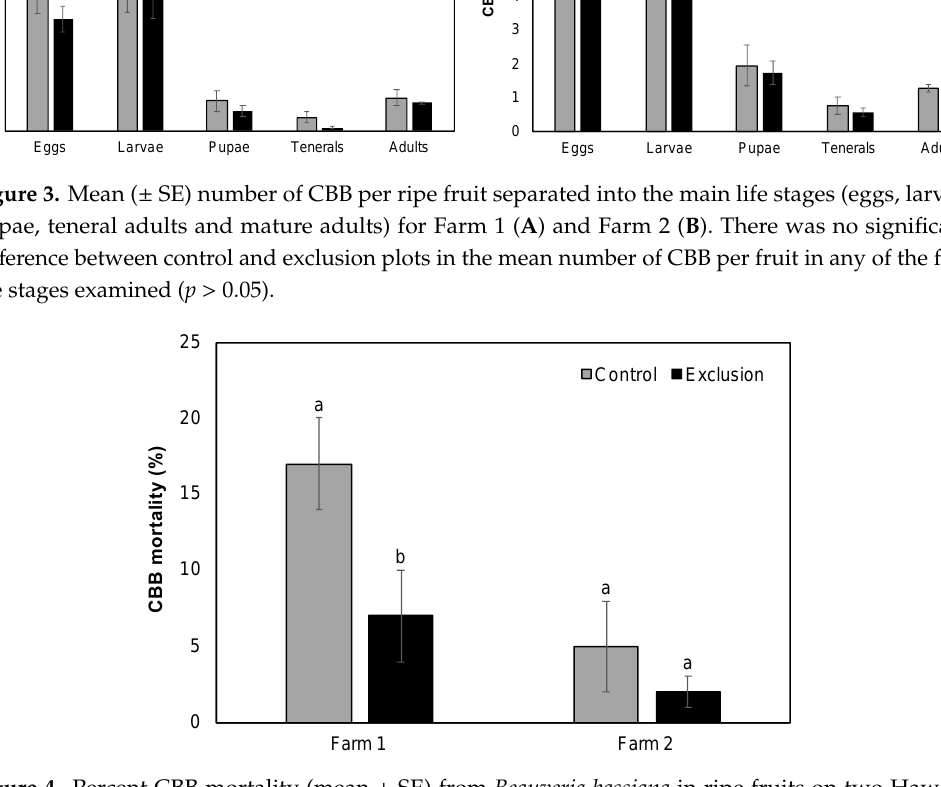
Figure 4. Percent CBB mortality (mean ± SE) from Beauveria bassiana in ripe fruits on two Hawai’i Island farms. Lowercase letters represent significant differences in the means.